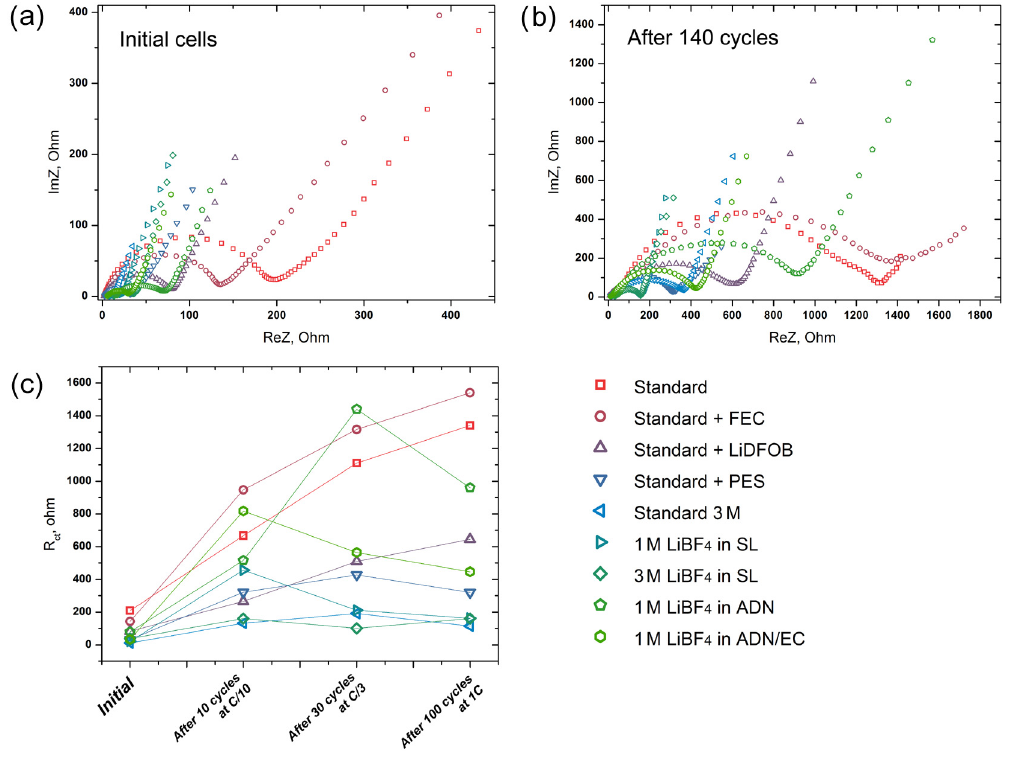
Figure 4. EIS Nyquist plots for the as-assembled cells ( a ) and after complete galvanostatic cycling: 10 cycles at C/10 rate, 30 cycles at C/3 rate and 100 cycles at 1C rate ( b ). Values of the charge transfer resistance (R ct ) at different stages of the cell cycling ( c ).